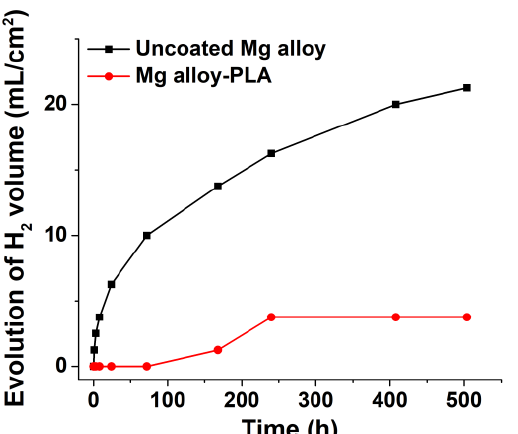
Figure 3. Evolution of H 2 release rate of uncoated Mg alloy and Mg alloy-PLA samples in SBF.